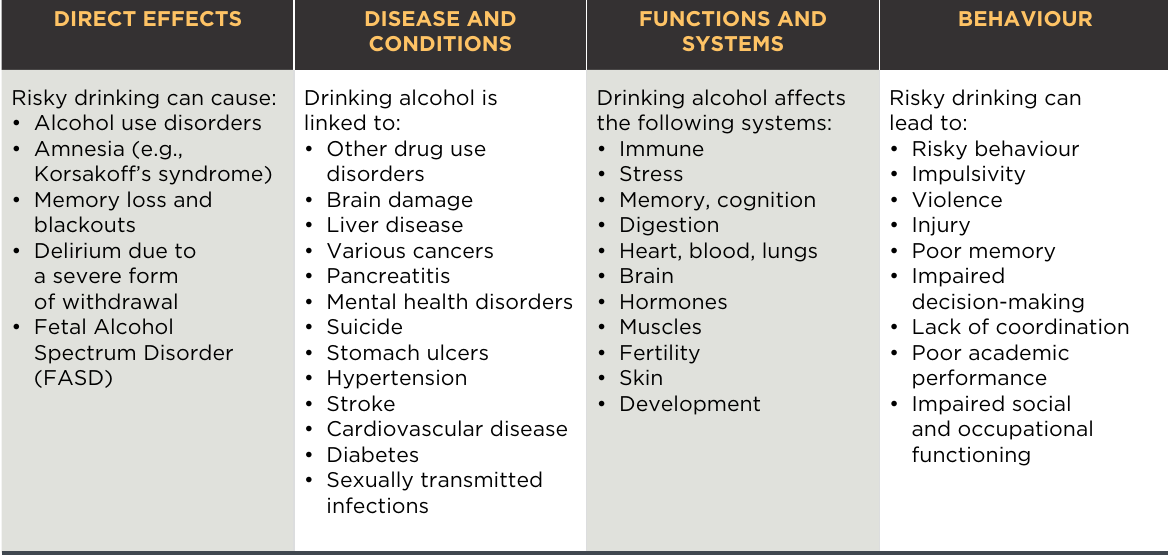
Table 1: AN OVERVIEW OF THE DOSE-DEPENDENT HEALTH AND BEHAVIOURAL IMPACTS OF ALCOHOL CONSUMPTION DIRECT